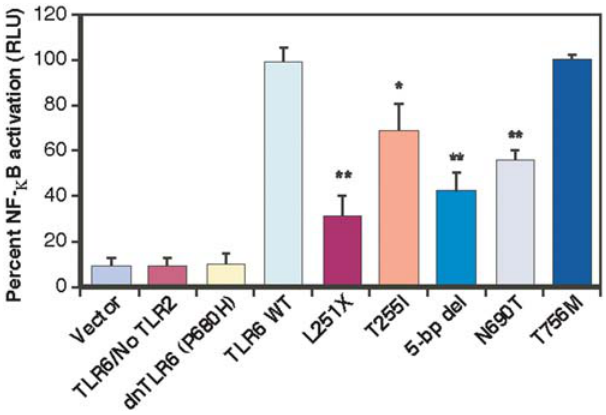
Figure 2. Altered NF- k B signal transduction by rare variants of TLR6. HEK 293 cells were transiently co-transfected with TLR2 and the indicated TLR6 variant expression plasmids, NF- k B reporter (firefly luciferase), and b -actin Renilla luciferase plasmids. NF- k B activation in transfected cells was measured 24 hrs post transfection. The data shown are the mean 6 SD from 4 independent experiments expressed as the percent relative firefly luciferase activity (RLU) (normalized to Renilla luciferase activity) induced in cells co-expressing TLR2 and WT TLR6 . * P , 0.01; ** P , 0.001 compared to TLR6 WT NF- k B activity.